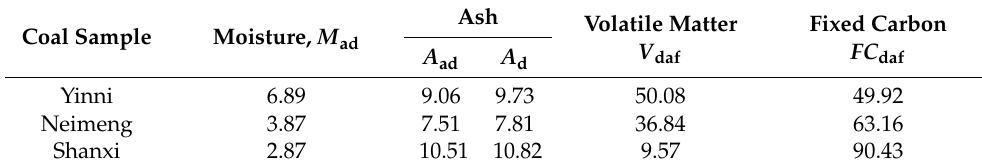
Table 1. Proximate analysis (wt.%) of coal samples. Coal Sample Moisture, M ad